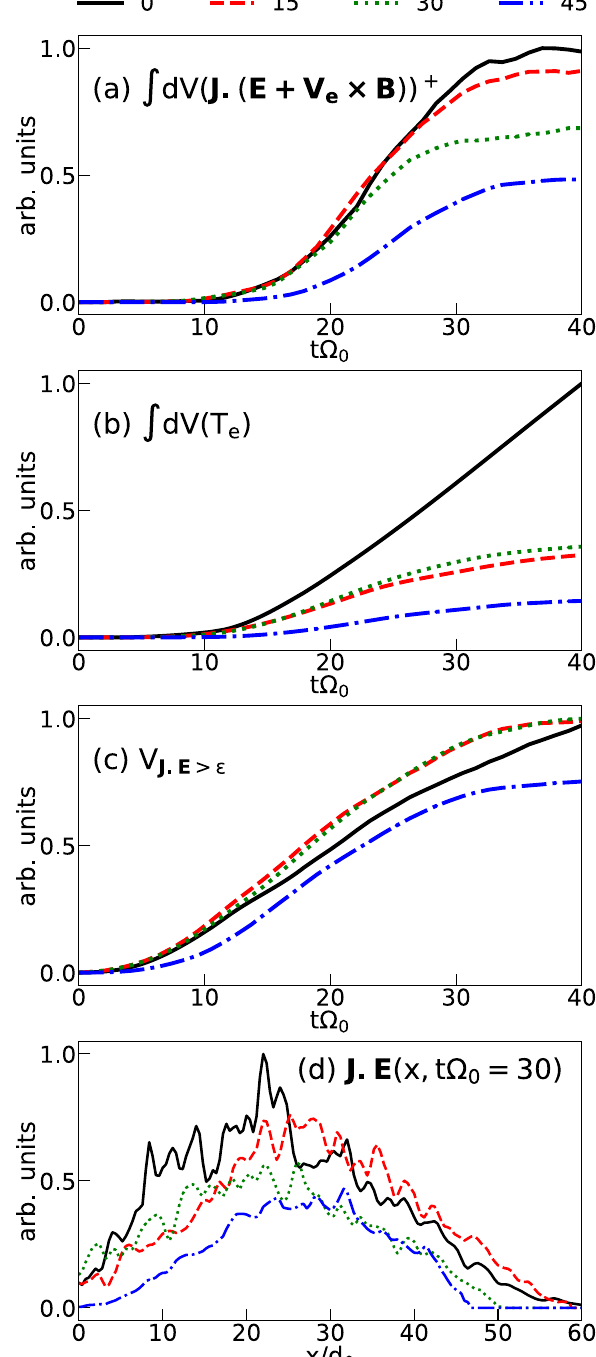
Fig. 5 | Temporal evolution of various simulated quantities. a Simulated power of the energy conversion from magnetic energy into plasmaenergy in the electron frame, which is related to the ef fi ciency of the reconnection process (see text). b Evolution of the space-integrated electron temperature retrieved in the simula- tions,herede fi nedasone-thirdoftheelectronpressuretensortracedividedbythe electron density. c Evolution of the diffusion volume. The diffusion volume is the volume where the integrand from a being greater than the numerical noise level, ϵ =10 − 8 .Theintegratedvolumeforthethreecomputedquantitiesislimitedinthey direction over − 5< y / d 0 <5. d x-dependency of the reconnection ef fi ciency: dis- sipation term ( J ⋅ ( E + v e × B )) integrated over the yz-plane at t =30 Ω (cid:1) 1 0 .